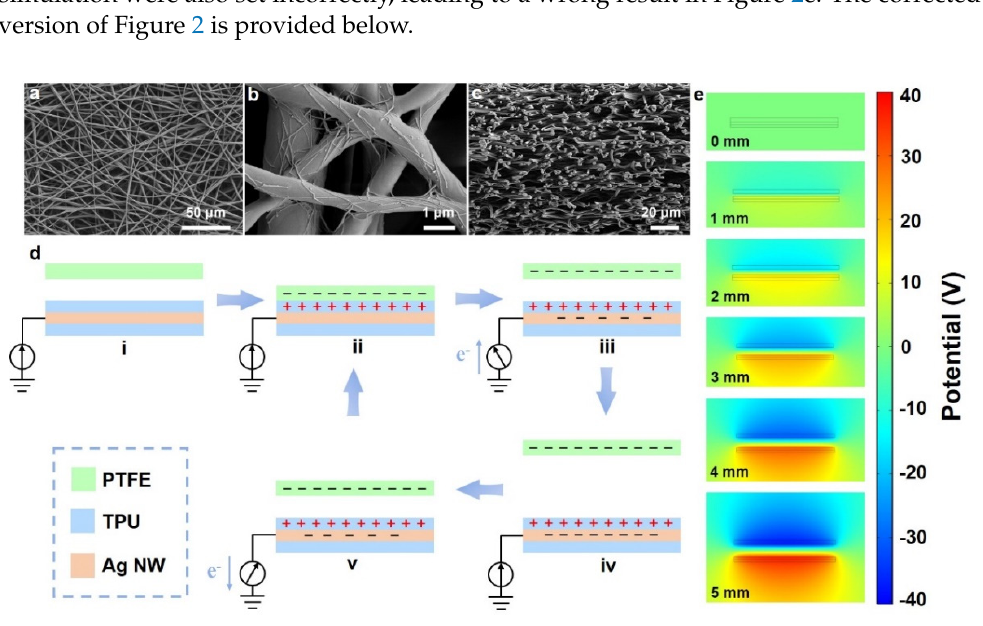
Figure 2. The micromorphologies and working mechanism of the TE-skin. ( a ) The SEM image of the TPU layer. ( b ) The SEM image of the Ag NW that is deposited on the TPU fibers. ( c ) The cross-section SEM image of the TE-skin. ( d ) The working mechanism of the TE-skin upon contact with skin. ( e ) The potential simulation by COMSOL to elucidate the working principle of the TE-skin. Text Correction There was an error in the original publication. As described in Section 3.2 of the paper, “...wherein the PTFE is electronegative in comparison with the TPU, due to the diverse triboelectric polarities”. However, the following writing of “Due to its ability to